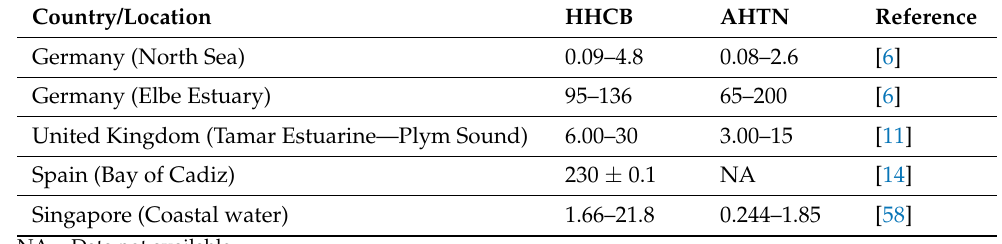
NA = Data not available.